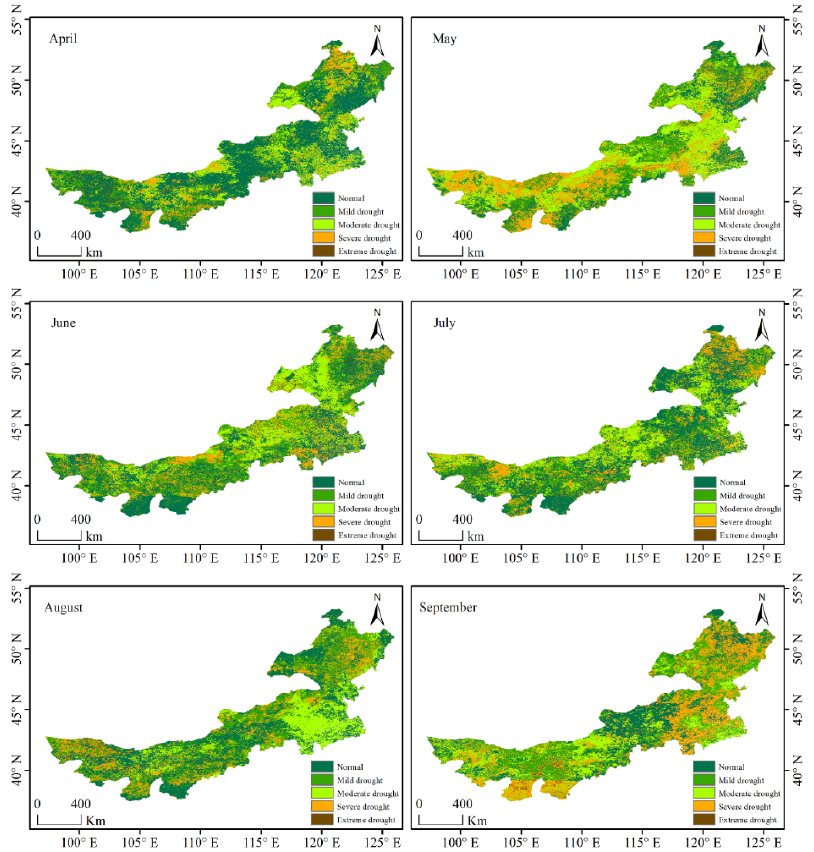
Figure 6. Monitoring results of the drought model during the growing season in 2017.